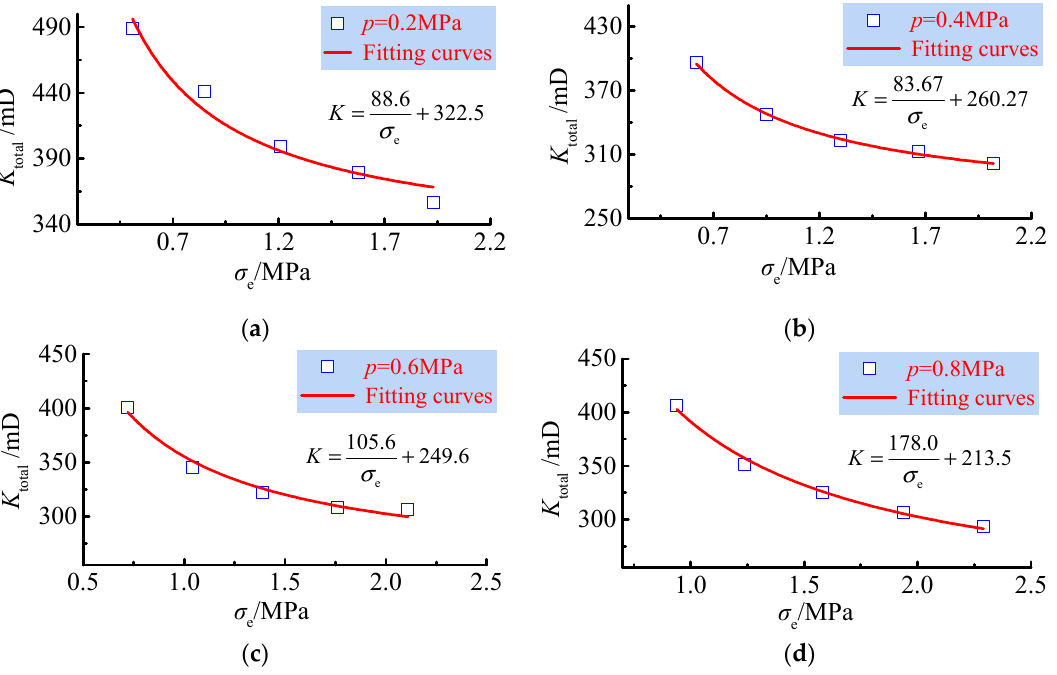
Figure 14. Total permeability versus effective stress. ( a ) The seepage pressure is 0.2 MPa; ( b ) the seepage pressure is 0.4 MPa; ( c ) the seepage pressure is 0.6 MPa; ( d ) the seepage pressure is 0.8 MPa.